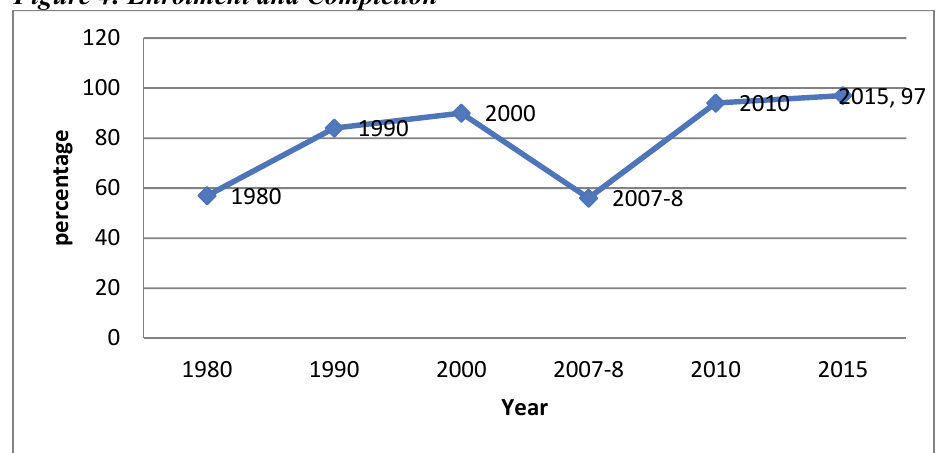
Figure 4: Enrolment and